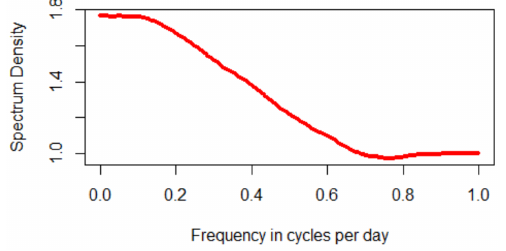
Figure 6. Power Spectrum of the Reputation signal for organisation BS, showing limiting cutoff frequency of approximately